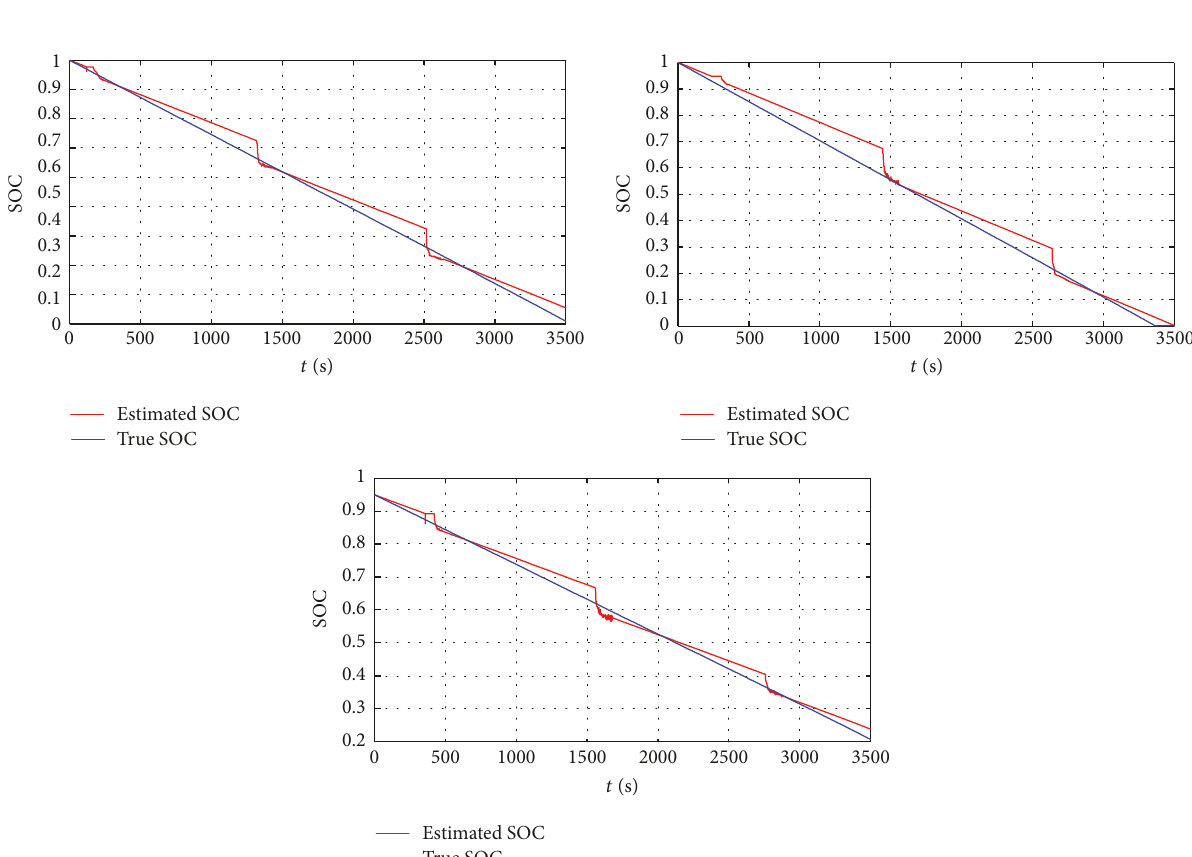
Figure 12: Comparison of SOC of battery cells estimated by proposed algorithm and true SOC of battery